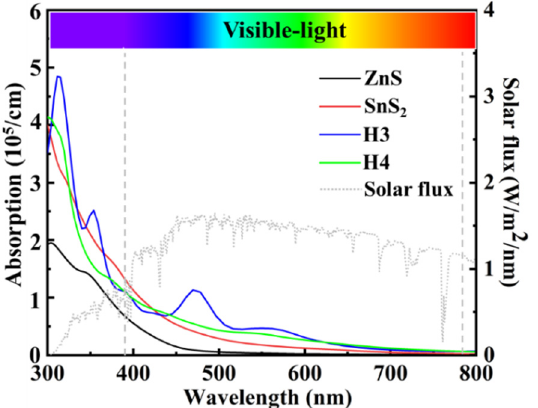
Figure 9. Optical absorption of ZnS monolayer, SnS 2 monolayer, and ZnS/SnS 2 (H3 and H4) hetero- junctions. The incident AM 1.5G solar flux is shown as a reference.